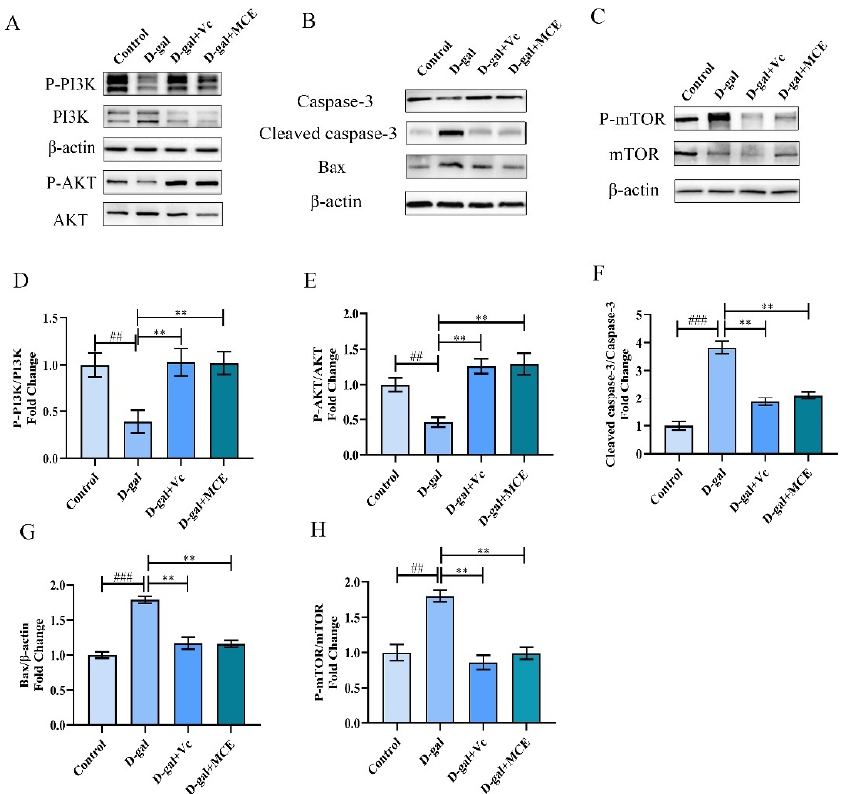
Figure 7. Effects of MCE on PI3K/AKT signaling pathway and downstream proteins. Representative Western blot images of P ‐ PI3K, PI3K, P ‐ AKT, AKT ( A ); caspase ‐ 3, cleaved caspase ‐ 3, Bax ( B ); P ‐ mTOR, mTOR ( C ); histogram of P ‐ PI3K/PI3K ( D ); P ‐ AKT/AKT ( E ); cleaved caspase ‐ 3/caspase ‐ 3 ( F ); Bax/ β‐ actin ( G ); P ‐ mTOR/mTOR ( H ). All results were normalized by β‐ actin and expressed as a fold change relative to the gray value of the control group. ### p < 0.001, ## p < 0.01 vs. control group; ** p < 0.01 vs. D ‐ gal group.